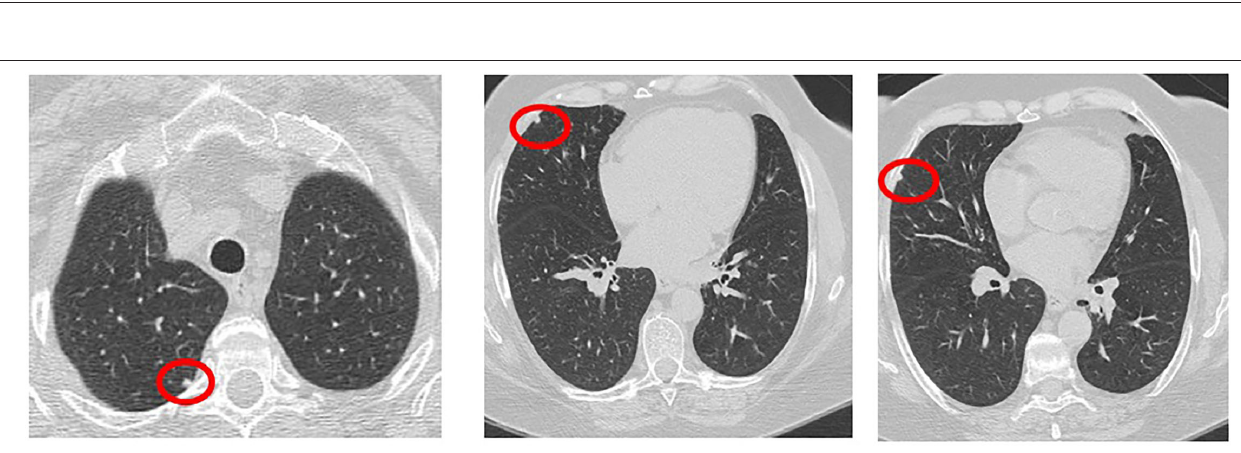
Frontiers in Medicine |